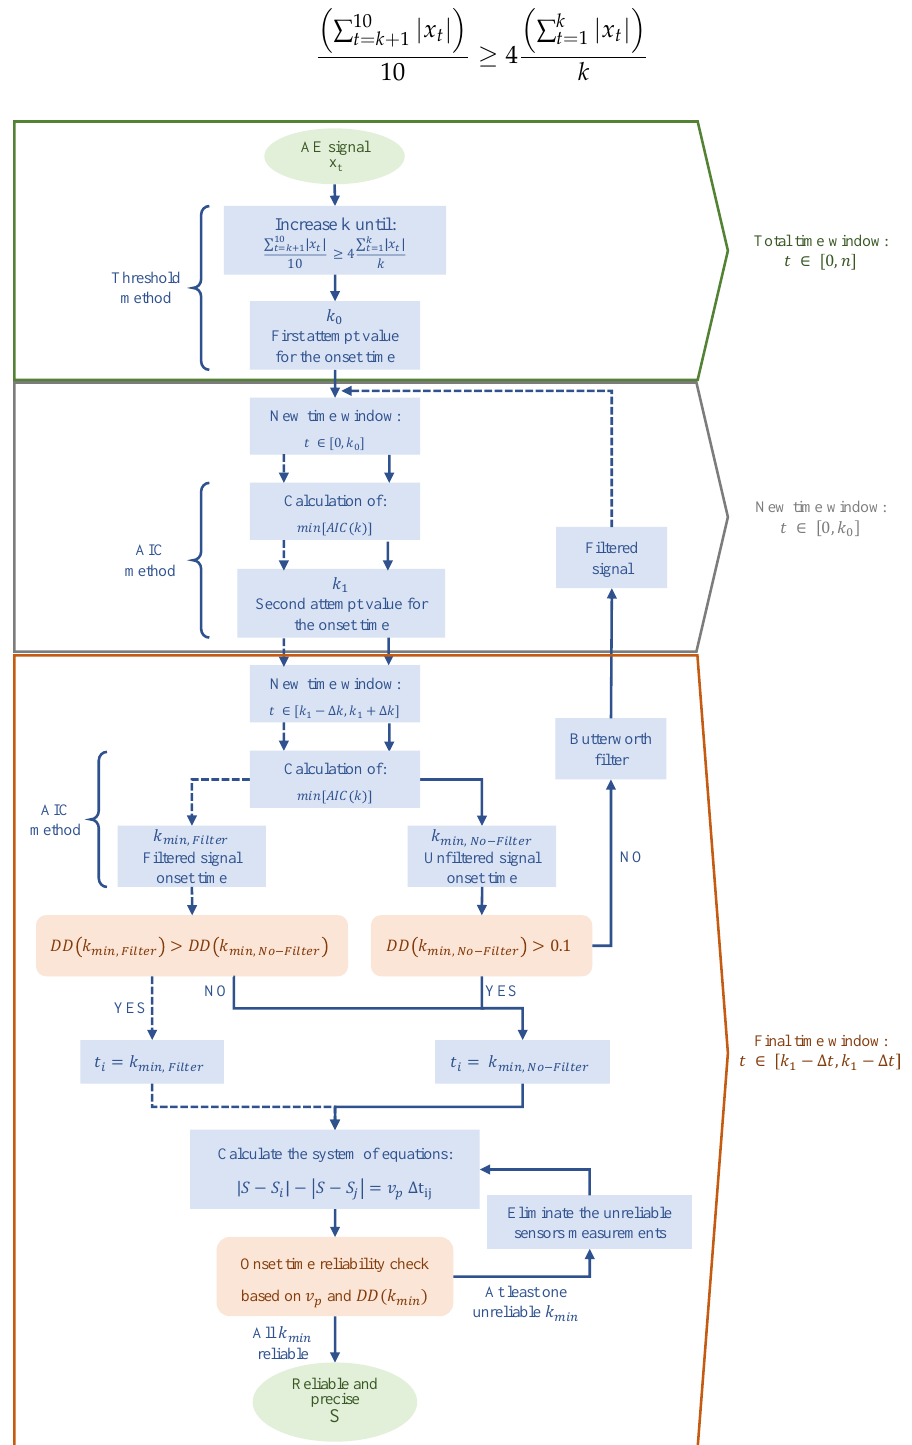
Figure 1. Improved AIC picker